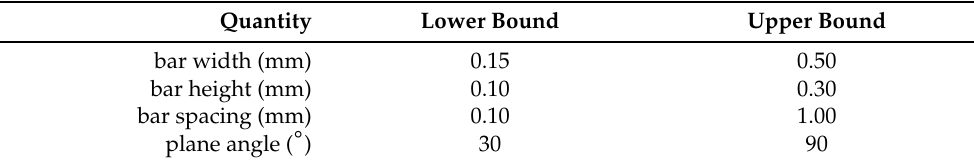
Table 6. Bounds for the evolutional optimization algorithm during absorber design.